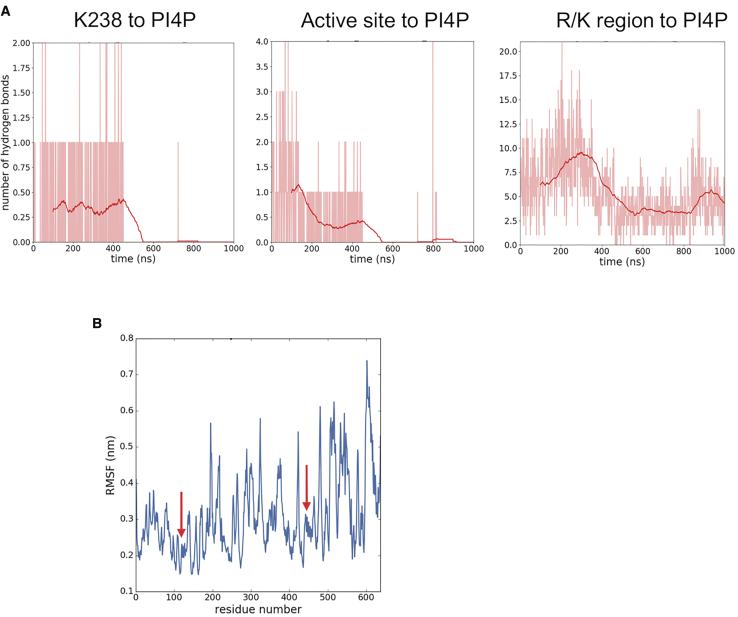
Atomistic Simulation of Membrane-Bound PIP5K1A Dimer(A) Hydrogen bonding interactions to PI4P for an atomistic simulation of the PIP5K1A dimer bound to a PC/PS/PI4P membrane (see Table 1). Hydrogen bonding (shown as instantaneous numbers in pink and as moving averages in red) for a PIP5K1A dimer bound to a PC/PS/PI4P membrane simulated over 1 μs. The K238 residue makes between 0 and 2 hydrogen bonds with PIPs in the membrane. Other residues in the active site also contribute to hydrogen bonding. Residues in the R/K-rich region are involved in an extensive hydrogen bonding network which shows small fluctuations over time but remains broadly between 5 and 10 hydrogen bonds over the course of the simulation while the dimer is bending.(B) RMSF as a function of residues number for a PIP5K1A dimer bound to a PC/PS/PI4P membrane. The arrows show the regions corresponding to the C helix that show reduced mobility.